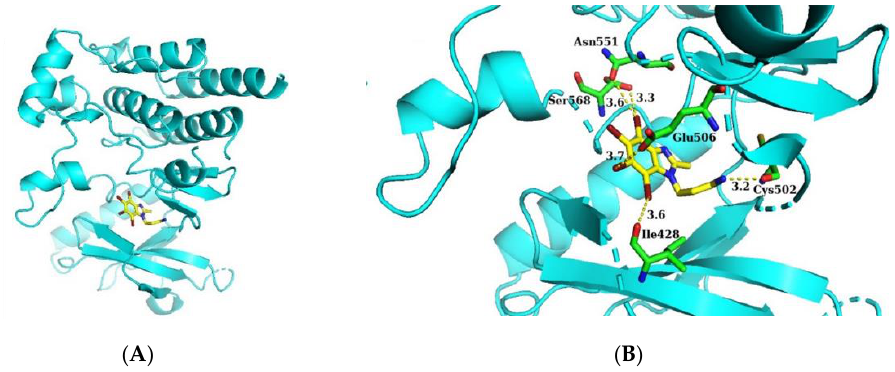
Figure 4. Binding model of 14B (in yellow) in the active site of FAK kinase: ( A ) Overall view; ( B ) details of binding.